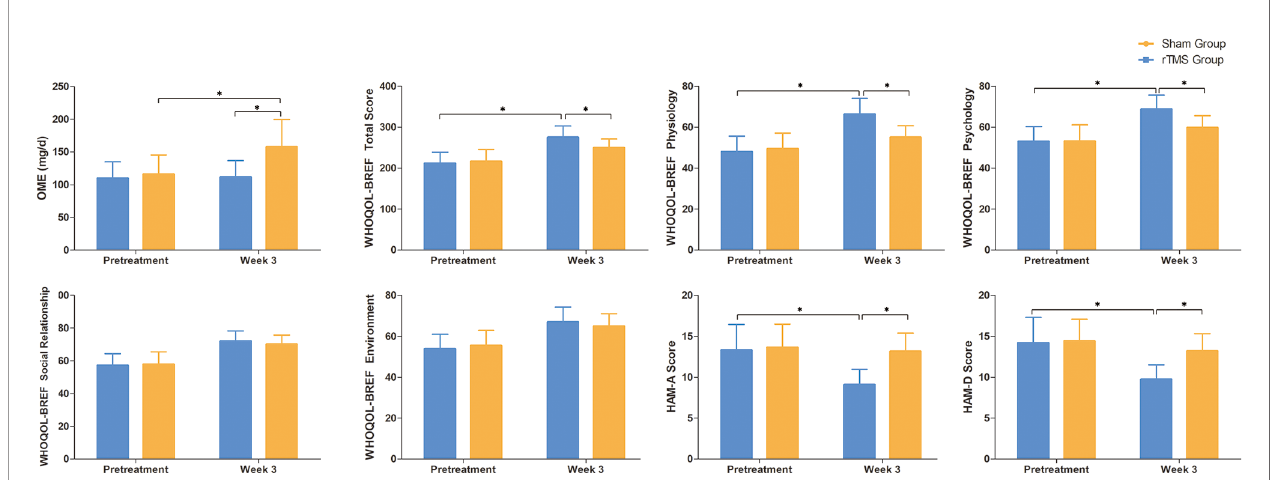
FIGURE 4 | Raw scores on secondary outcomes at baseline and weeks 3. Error bars indicate 95% con fi dence intervals, * indicate signi fi cant inter-group or pre- post differences, P < 0.05. OME, Oral morphine equivalent; WHOQL-BREF, WHO Quality of Life-BREF; HAM-A, Hamilton Anxiety Scale; HAM-D, Hamilton Depression